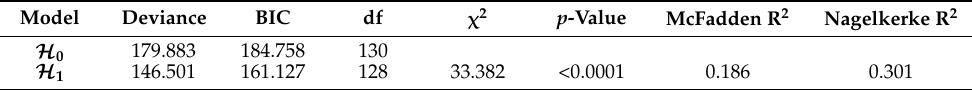
Table 6. Summary of the logistic model characterizing the relationship between the variable Y 1 : “Have you been infected with COVID-19?” and the variables X 2 and Z 2 (Model 2).